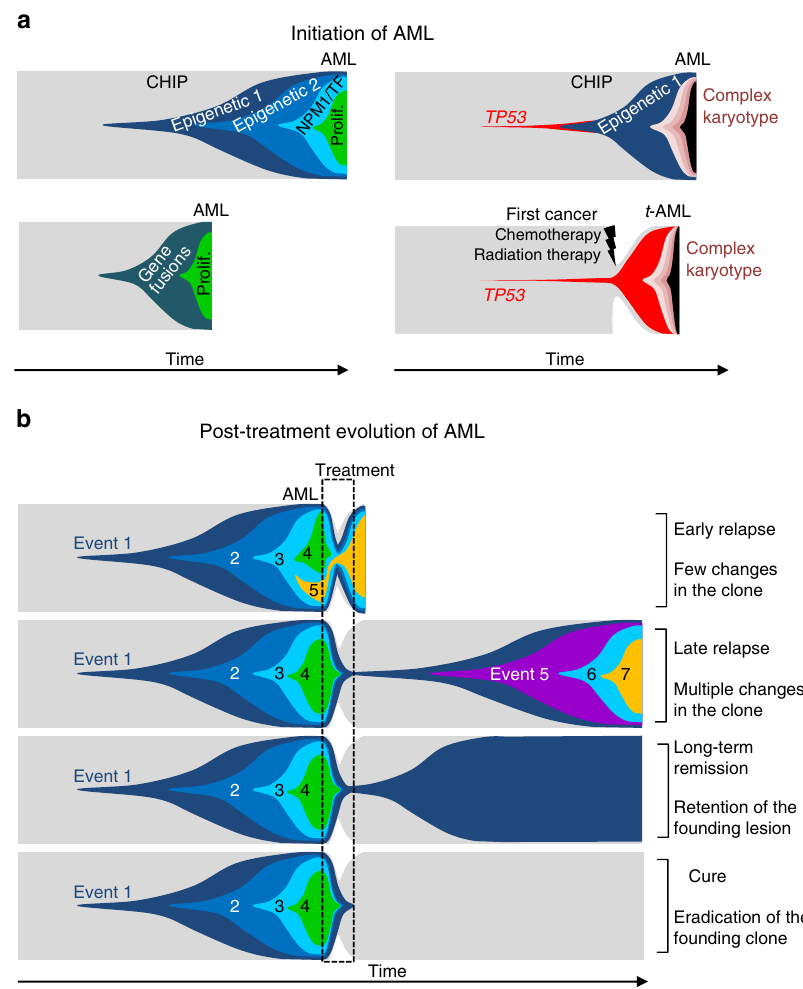
Figure 7 | The action of time and treatment selection pressure in the initiation and evolution of AML. ( a ) Schematic representation of the initiation and evolution of the malignant clone (coloured areas) at the expense of normal HSPCs (grey area) from the acquisition of the first event to the onset of AML. Left diagrams show AMLs emerging after the occurrence of the first lesions which endow HSPCs with enhanced expansion capacity. Right diagrams depict AMLs with TP53 mutations. For therapy-related AMLs (t-AML), the occurrence and treatment of a first cancer, followed by HSPC depletion and recovery, are indicated. The nature of each lesion is indicated as follows: Epigenetic 1: mutations in DNMT3A , TET2 , ASXL1 ; Epigenetic 2: Epigenetic 1 or other mutations in epigenetic modifiers; Gene fusions: CBF or MLL translocations; NPM1 /TF: mutations in NPM1 or haematopoietic transcription factors; Prolif.: mutation in proliferation/signalling pathways; TP53 : TP53 mutations. ( b ) Post-treatment evolution of AML, according to various outcomes. CHIP, clonal haematopoiesis of indeterminate